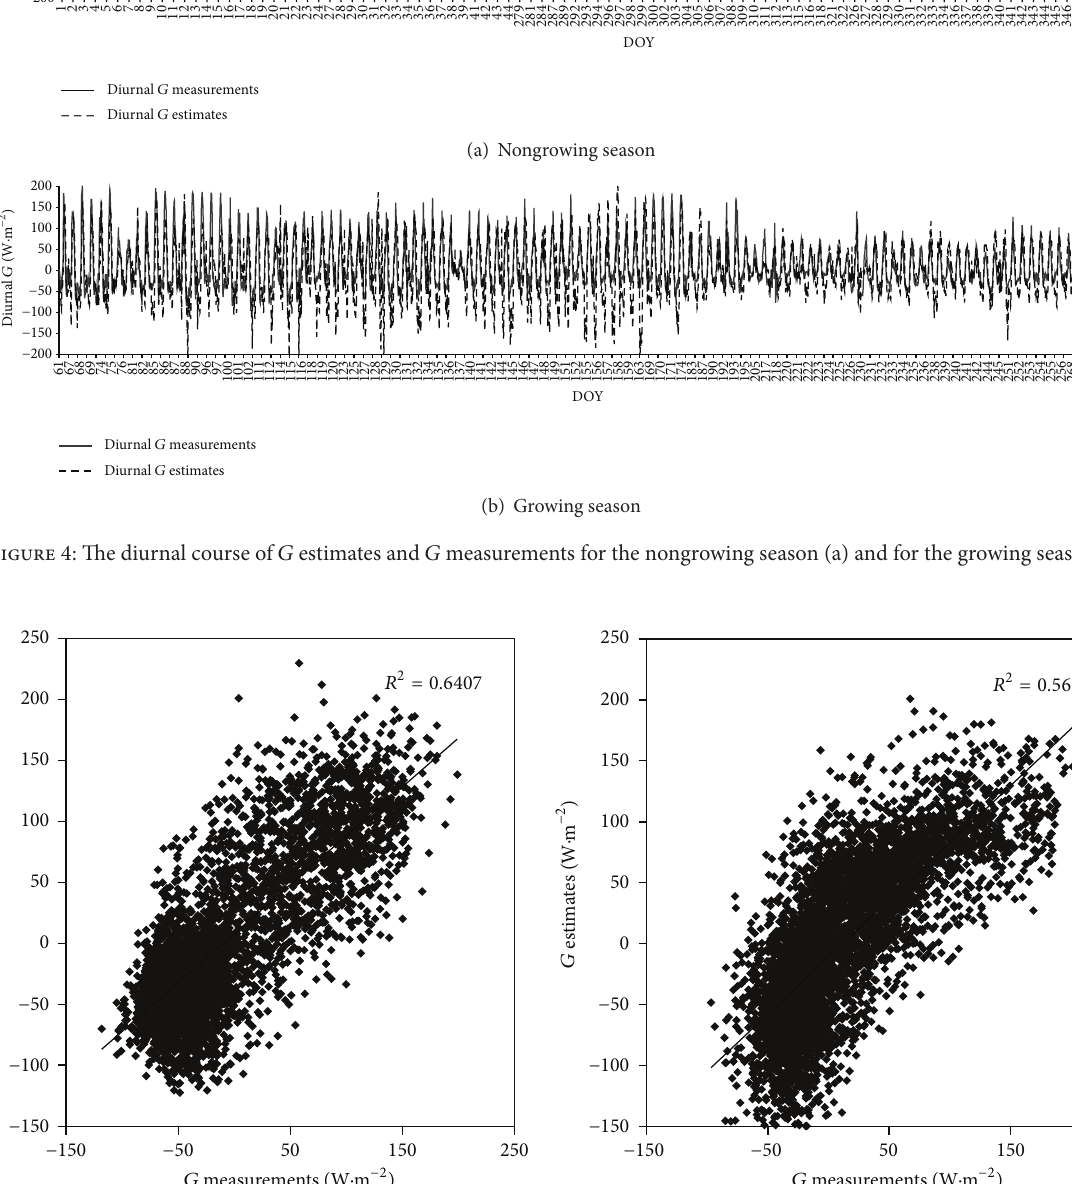
the soil due to the effect of the sheltering of the soil surface by the canopy coverage. In the study, canopy temperature calcu- lated from the radiative measurements by a four-component radiometer was used to compute the summation of harmonic terms in (10). Thus, the influence of canopy temperature